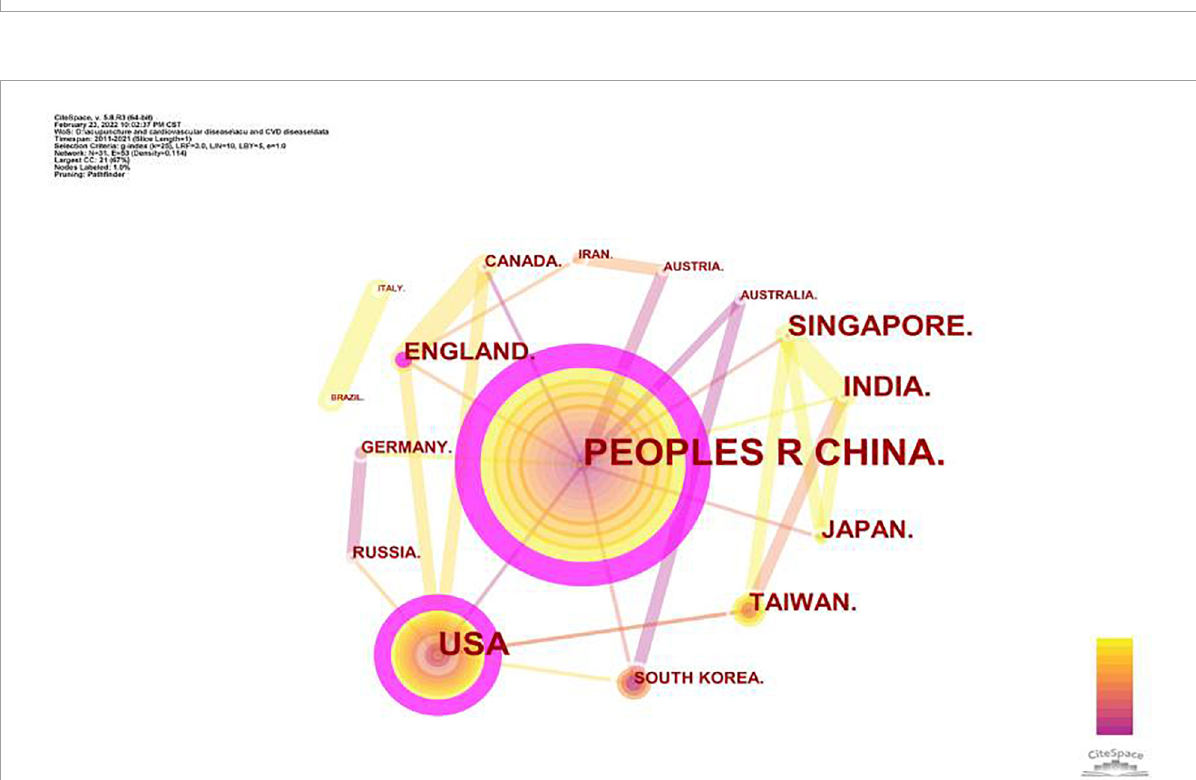
FIGURE2 Network map of co-authorship between countries or regions about acupuncture on